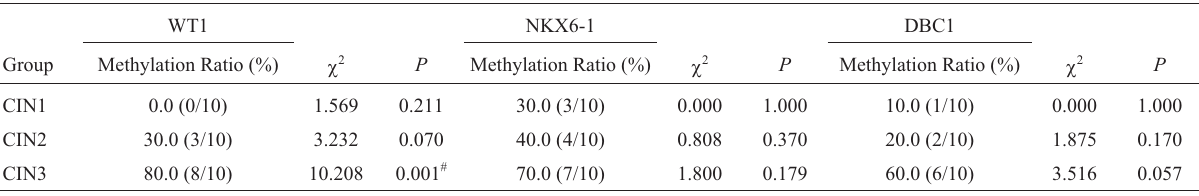
Table 5 - Methylation ratios of WT1, NKX6-1, DBC1 in CIN tissues. WT1